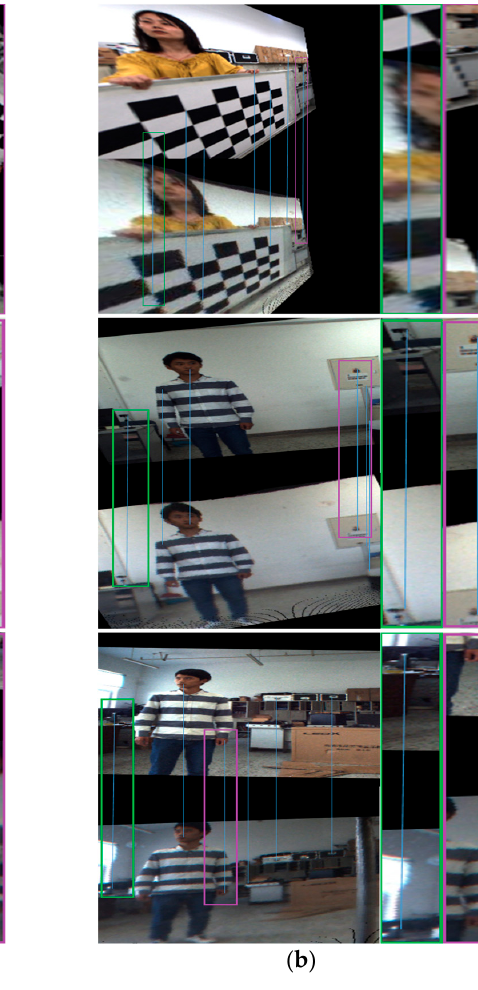
Figure 9. Stereo rectification results. The first row in each image is from the conventional camera. The second row in each image is from the omnidirectional camera. ( a ) The image pair with the rectification method in [27]; ( b ) the image pair with our proposed rectification method.